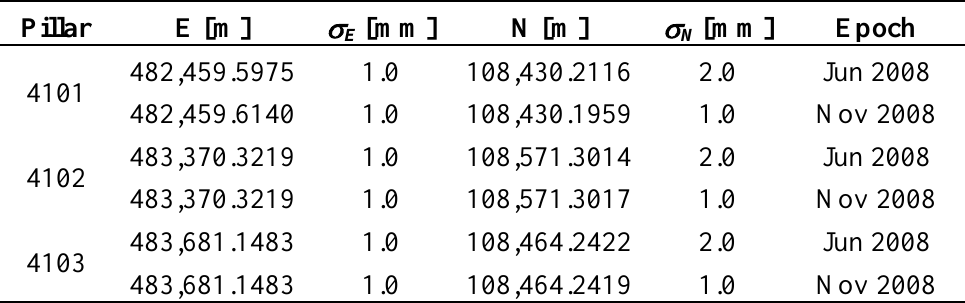
Table 3. Estimated coordinates of reference